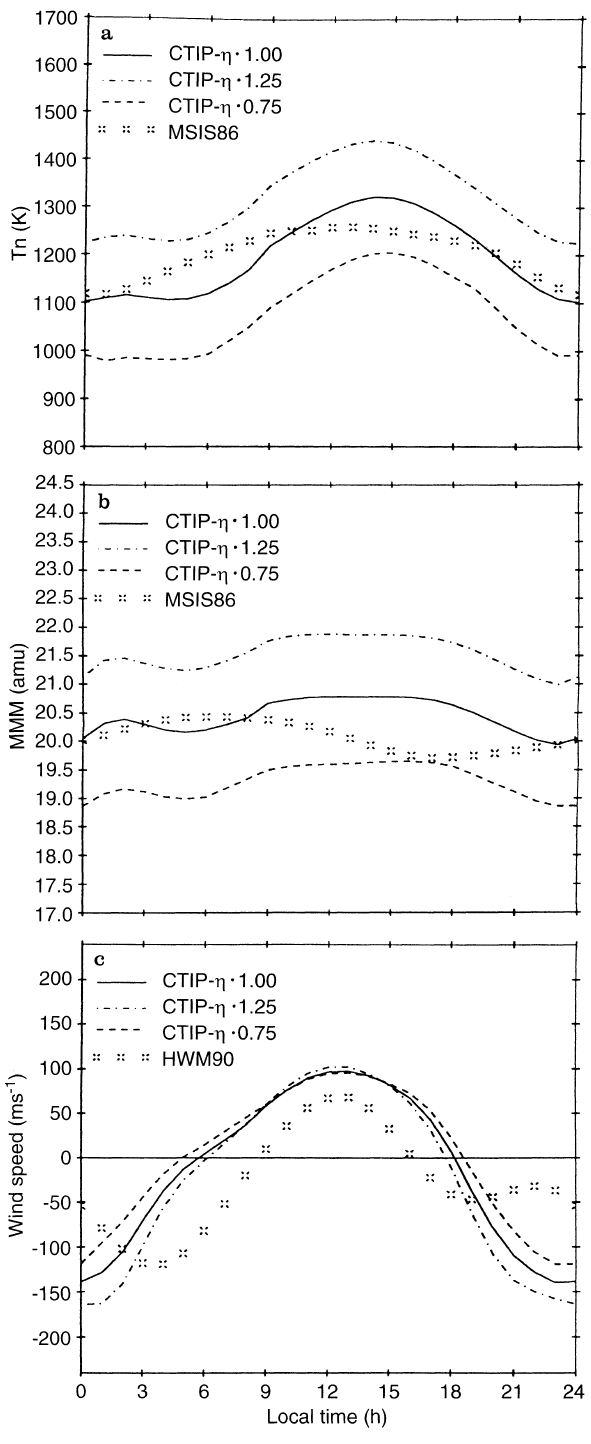
Fig. 8a–c. The sensitivity of a T n ; b mmm and c V x (positive polewards), at 300 km over Argentine Islands, to changes in the magnitude of thermospheric